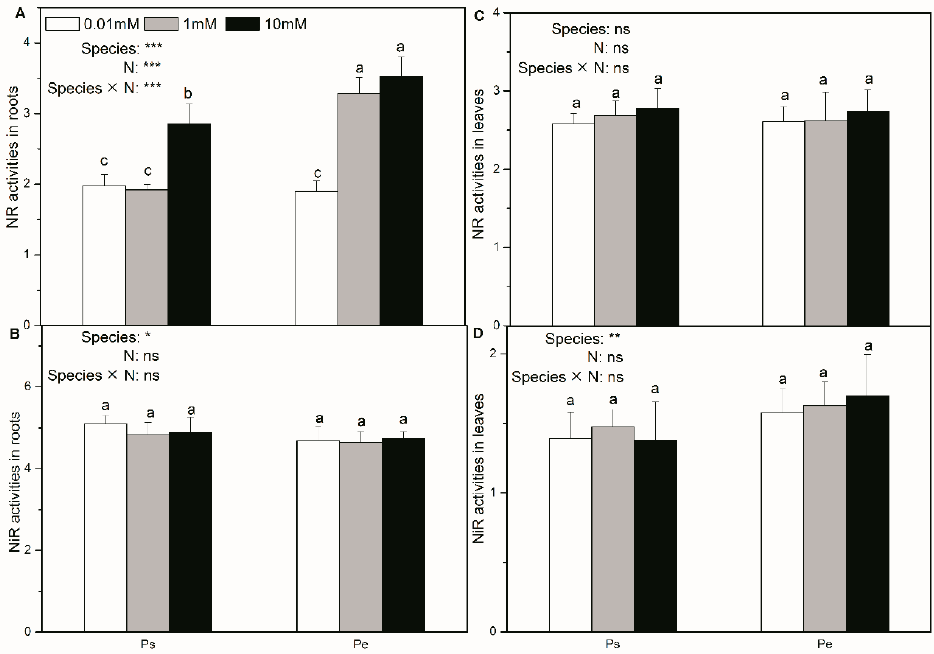
Figure 7. NR ( A , C ) and NiR ( B , D ) activities of P. simonii (Ps) and Populus euramericana (Pe) under 0.01, 1, and 10 mM NH 4 NO 3 . Bars labelled with different letters indicate significant difference between the